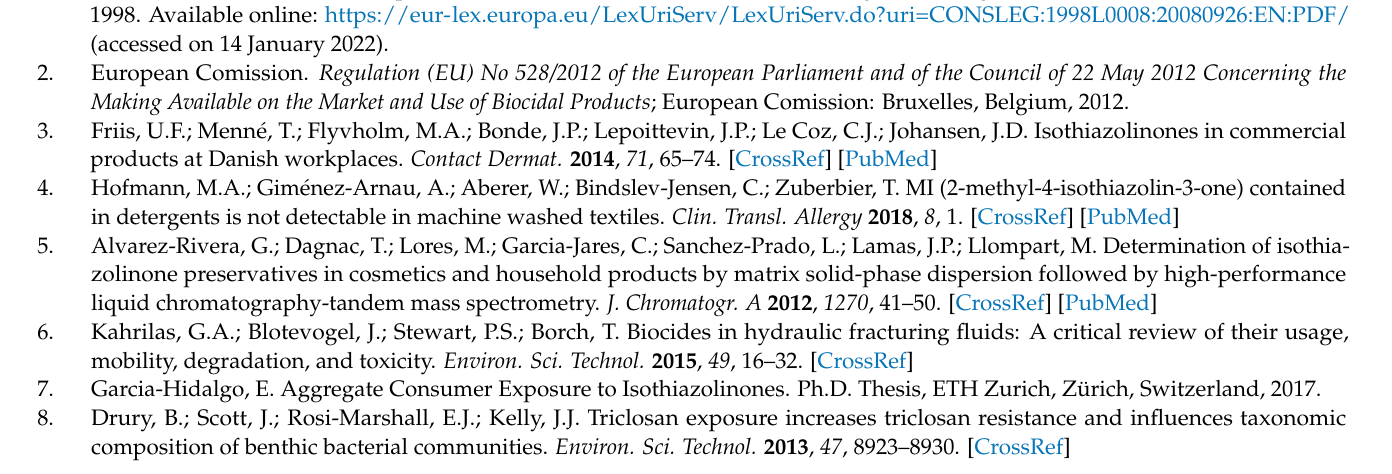
codification. Table S3. Inter-day and intra-day precision, the method recoveries, limit of detection (LOD) and limit of quantification (LOQ) values determined for commercial products. Table S4. Inter-day and intra-day precision, the method recoveries, limit of detection (LOD) and limit of quantification (LOQ) values determined for environmental samples. Table S5. Summary for the concentration levels (mg/L, mean ± standard derivation, n = 3 of 4 biocides in commercial products. Table S6. Summary for the concentration levels (mean ± standard derivation, n = 3) of 4 biocides in environmental. Table S7. Toxicity data: Enf Point, Effect concentration, AF, PNEC. Table S8. Risk quotients derived from BIT and OIT. Figure S1. Chromatograms of 5 mg/L biocide standard mixture and their corresponding UV spectrum. Figure S2. Chromatogram registered for DW VL sample and the corresponding UV spectrum for BIT, OIT and CMI. Figure S3. Chromatogram registered for EF VL sample and the corresponding UV spectrum for BIT and CMI. Figure S4. Chromatogram registered for SS GL sample and the corresponding UV spectrum for